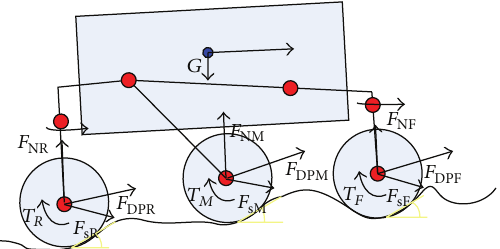
Figure 6: Lateral view of dynamics model based on wheel-soil mechanics during climbing of WMR on loose sloped